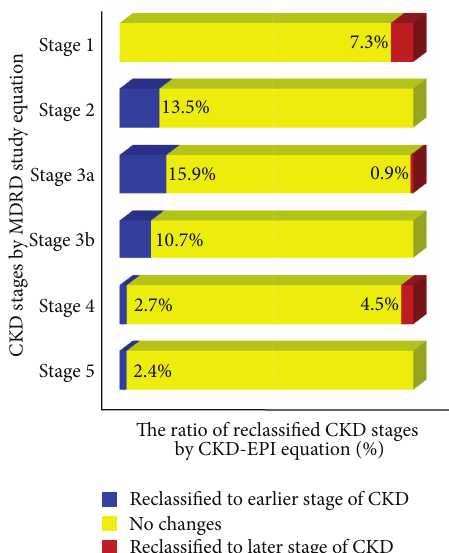
Figure 1: Ratio (%) of chronic kidney disease (CKD) stages for the modification of diet in renal disease (MDRD) study equation reclassified by the chronic kidney disease epidemiology collabo- ration (CKD-EPI) equation. Blue bars indicate reclassification to earlier stage of CKD; yellow bars, no reclassification; red bars, reclassification to later stage of